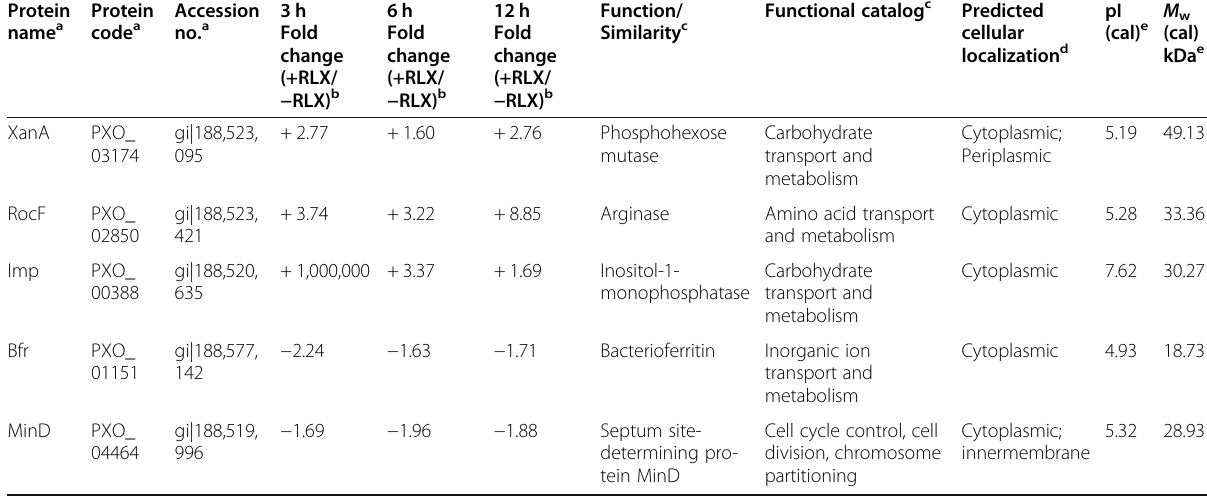
Table 1 Proteins exhibited significantly different expression patterns (|fold change| > 1.5) in X . oryzae pv. oryzae at all three time points after susceptible rice leaf extract (RLX) treatment